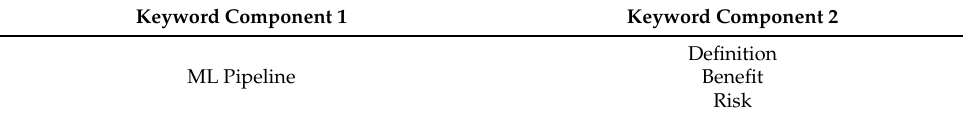
Table 2. Literature Review Keywords—ML Pipeline.